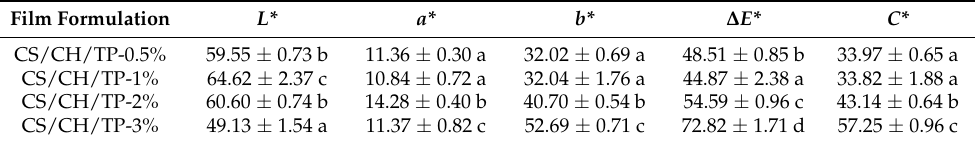
The color values of L* : luminosity, a* : negative green and positive yellow, b* : negative blue and positive yellow. Values are given as mean ± standard deviation. Different letters in the same column indicate significantly different ( p < 0.05) when analyzed by Duncan’s New Multiple Range